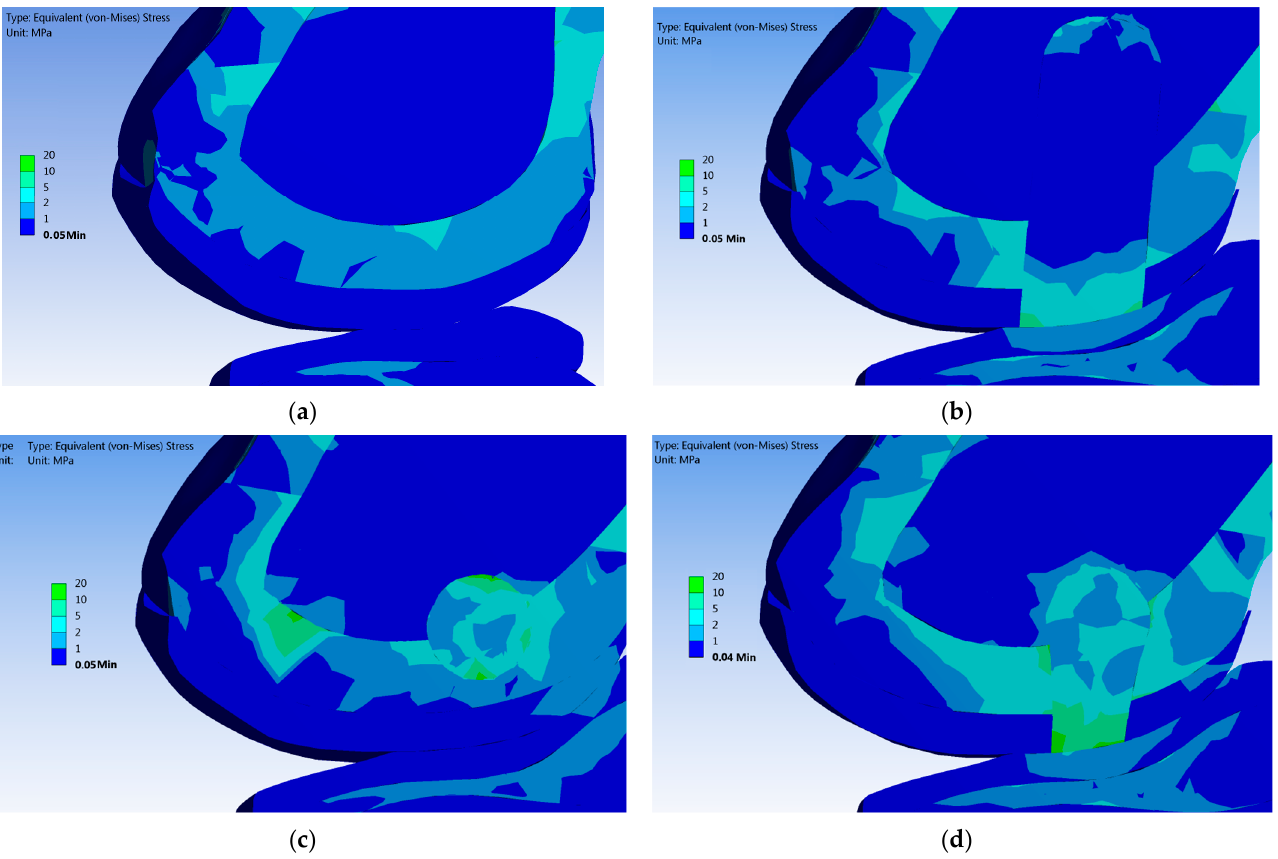
Figure 6. Distribution of von Mises stress in contact area of cartilage, after applying a normal pressure of 0.38 MPa: ( a ) Case 0 (healthy knee); ( b ) Case 1 (just porous Collagen); ( c ) Case 2 (Collagen + BMC); ( d ) Case 3 (Collagen + ASC). Table 2. Maximum von Mises stress in contact region after applying a normal pressure vs. a high pressure.